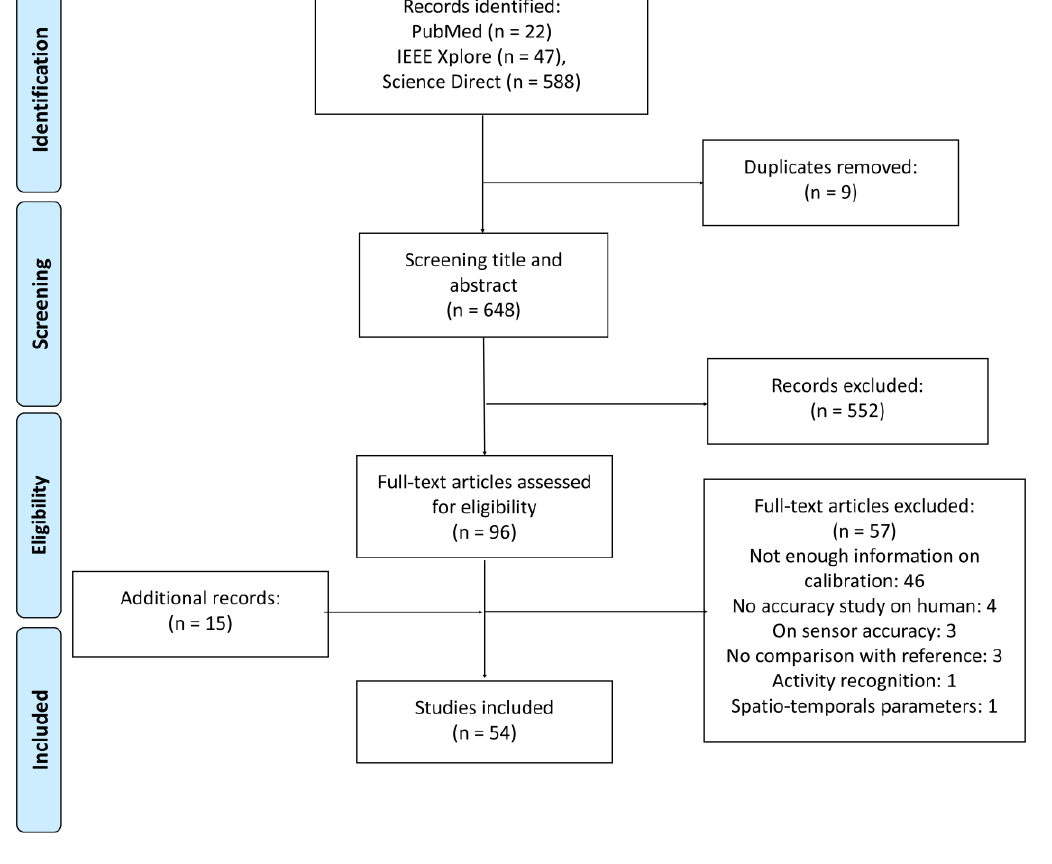
Figure 1. Flow diagram of search strategy.